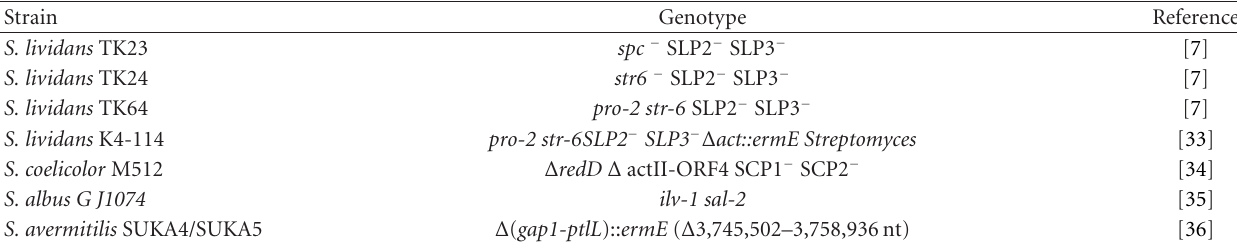
Table 3: Streptomycetes